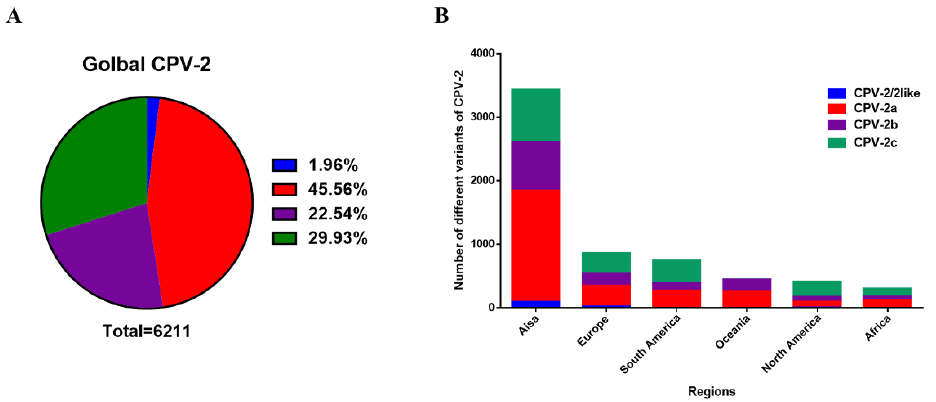
Figure 2. The number of CPV-2a/2b/2c variants. ( A ) Proportion of global CPV-2a/2b/2c. ( B ) Proportion of CPV-2a/2b/2c on each continent.